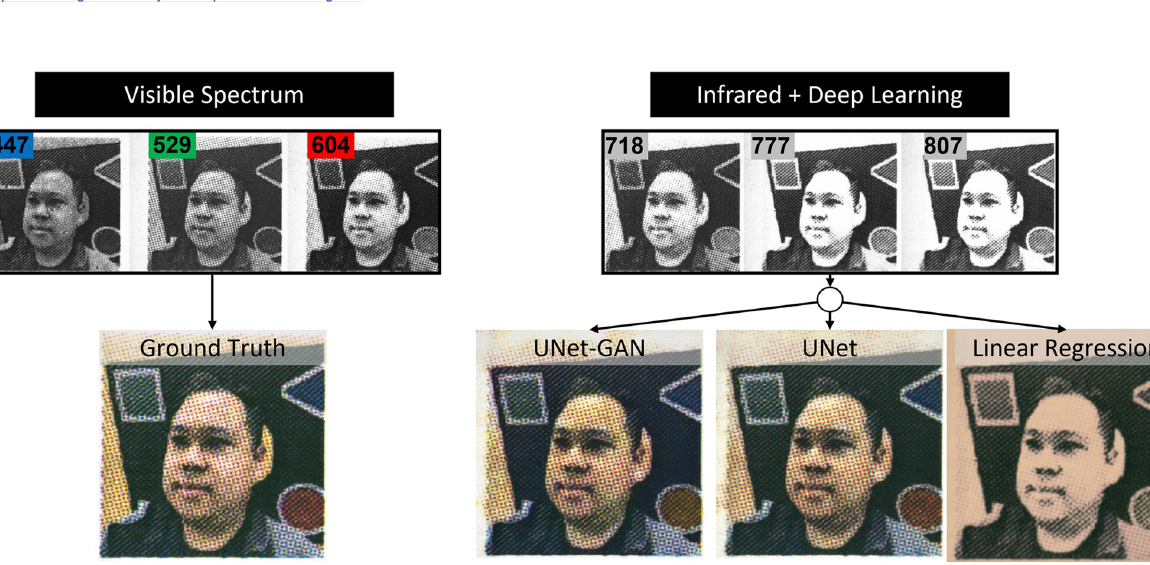
Fig 8. Models comparison with a regression baseline. FID scores for the baseline linear regression (FID score: 180.5), UNet (FID score: 140.8) and UNet-GAN (FID score: 87.2) on the same test set.